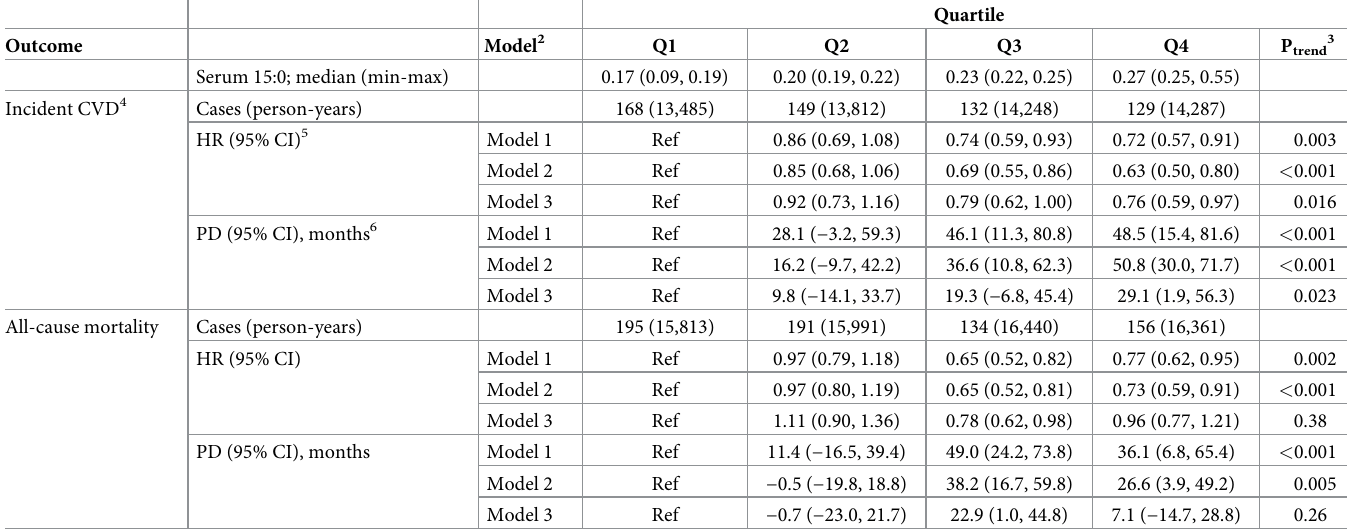
Table 3. HRs and 15th PDs of incident CVD and all-cause mortality by quartile of serum pentadecanoic acid (15:0) in the 60YO study 1 .